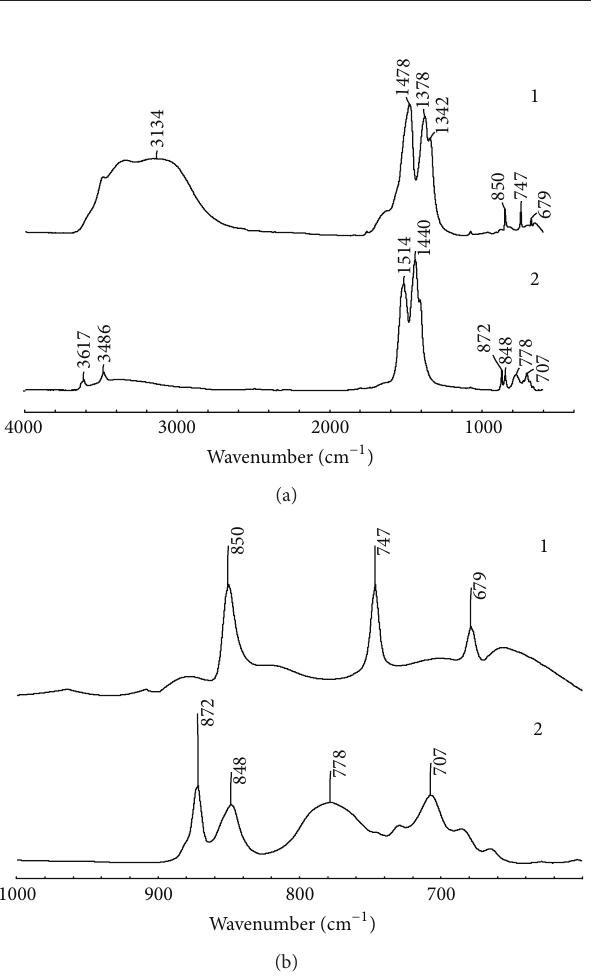
Figure 4: (a) FTIR spectra of La 2 (CO 3 ) 3 ⋅ 8H 2 O (line 1) and La(OH)CO 3 (line 2). (b) FTIR spectra of La 2 (CO 3 ) 3 ⋅ 8H 2 O (line 1) and La(OH)CO 3 (line 2) in the fingerprint region (1000–600cm −1 ).